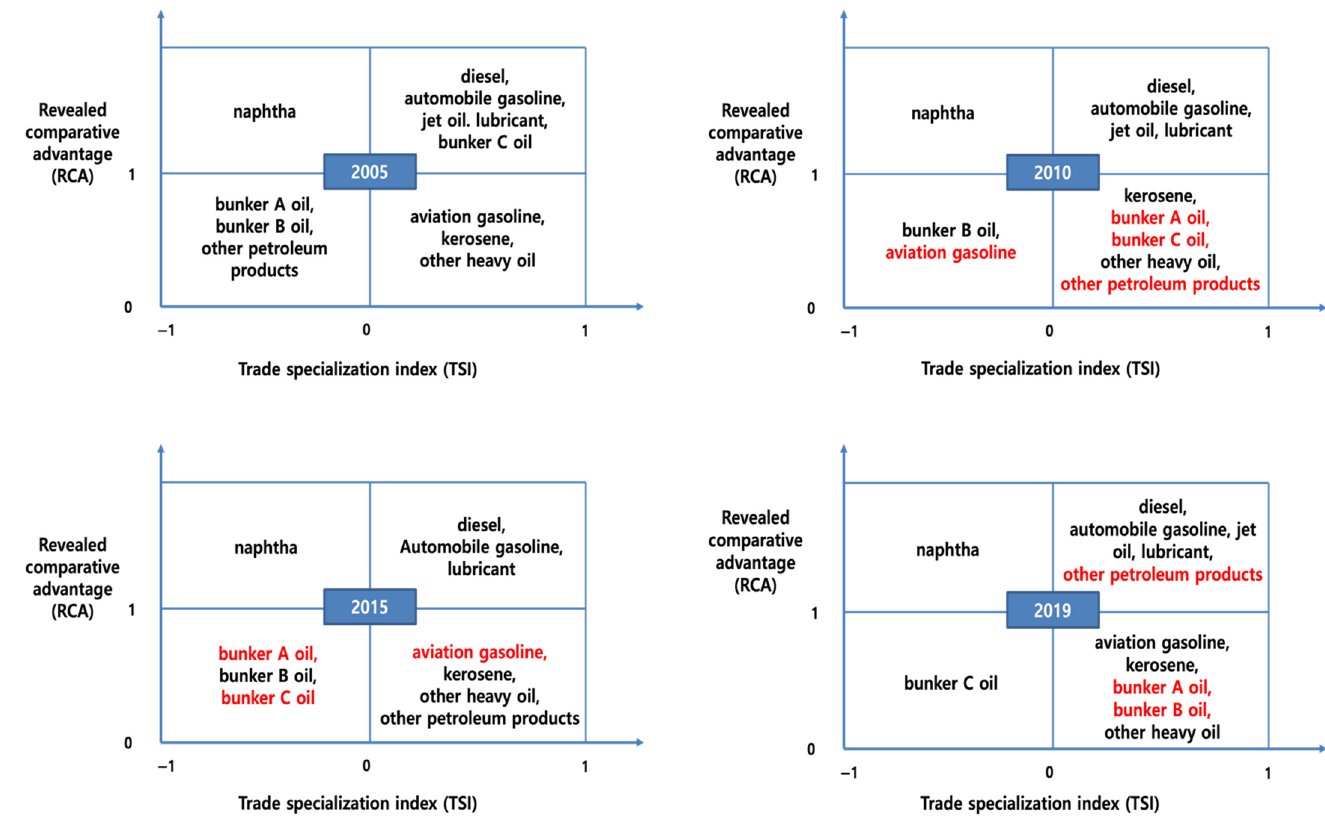
Figure 6. Dynamic changes of portfolio classification consisting of trade specialization index and revealed comparative advantage index.